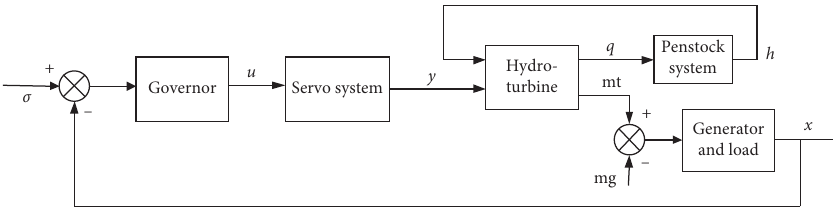
Figure 1: The structure diagram of